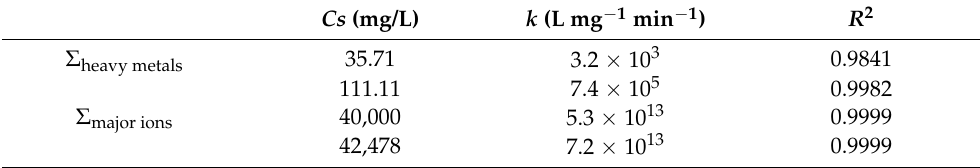
Table 4. Kinetical parameters derived from the empirical second-order reaction model.